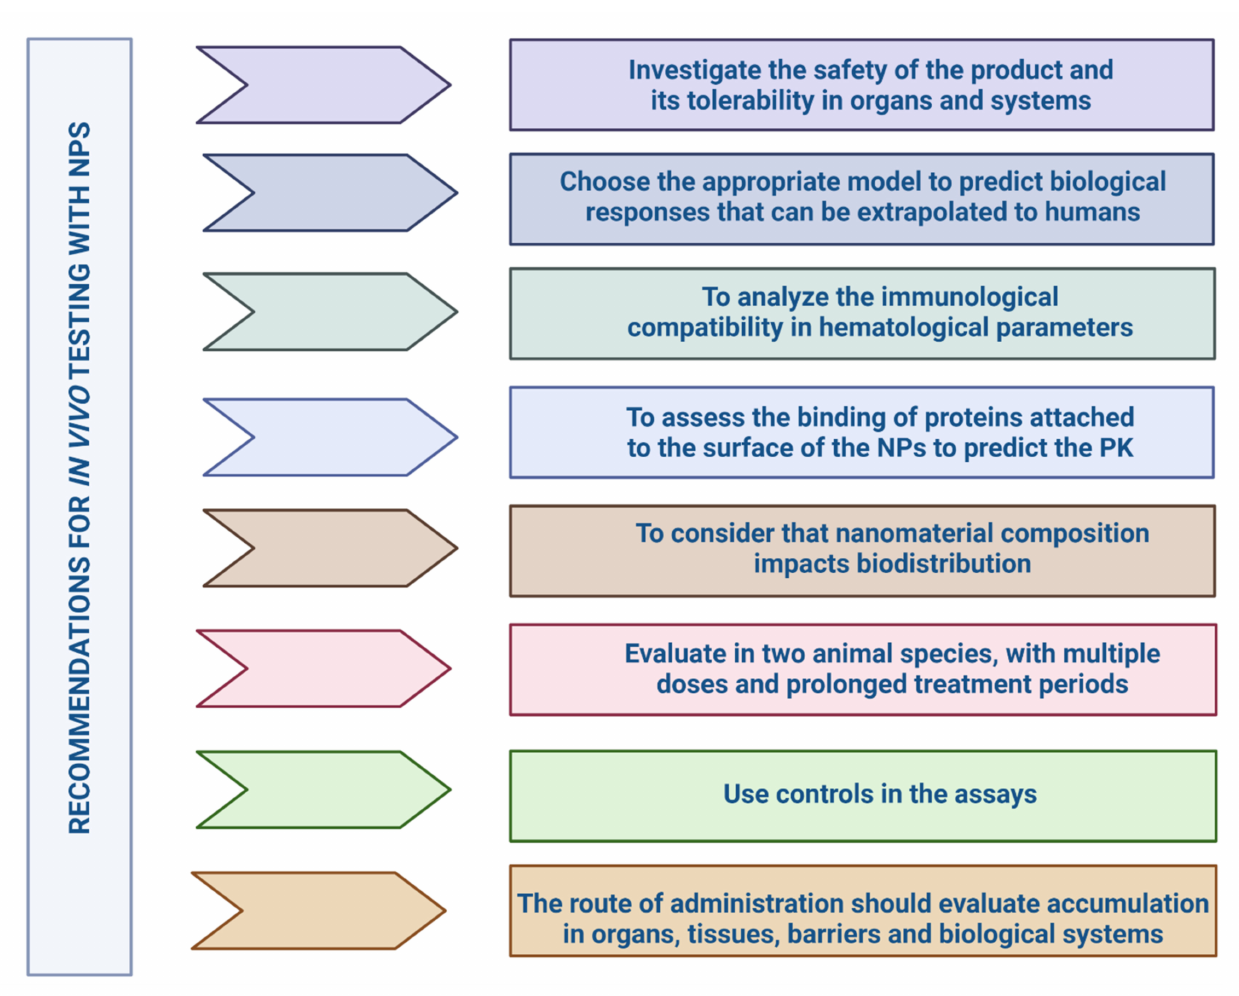
Figure 6. Recommendations for evaluating NPs in in vivo systems. PK: Pharmacokinetics. Created with BioRender.com (accessed on 10 December